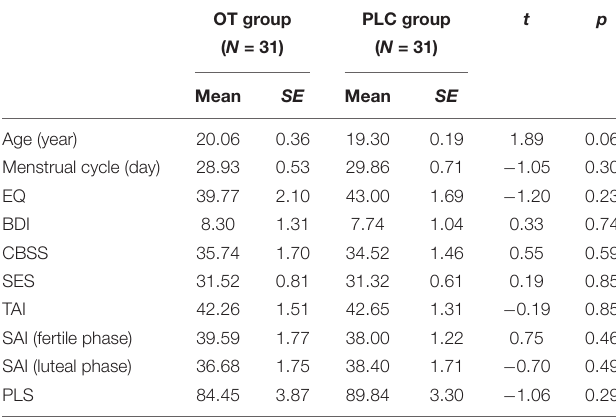
TABLE 1 | Demographic info and psychological measurements of